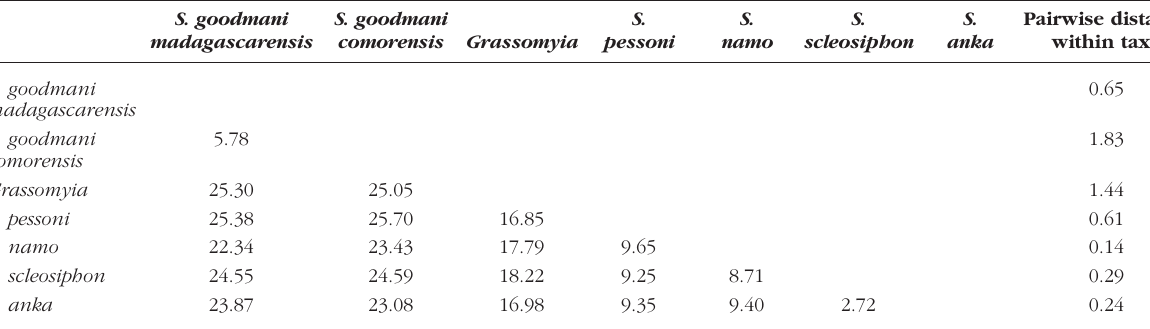
Table III. – Pairwise genetic distances (%) between and within